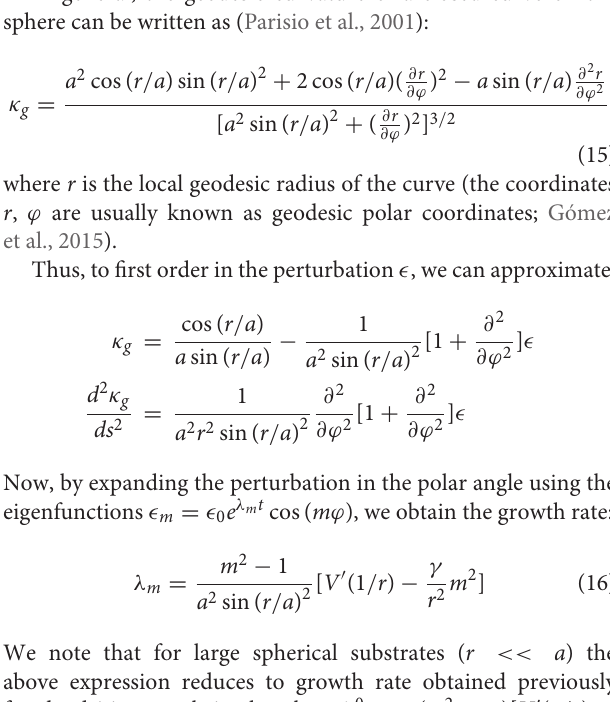
FIGURE 9 | Temporal evolution of a large crystal seed. This figure shows the temporal evolution of a large crystal seed of geodesic radius of r / a a sphere of radius a 2. Panels (A–D) correspond to = t 0.26,0.11,0.18,0.26, respectively. Note that tip-splitting is replaced by tip = narrowing. The color bar shows the amplitude of the order parameter φ